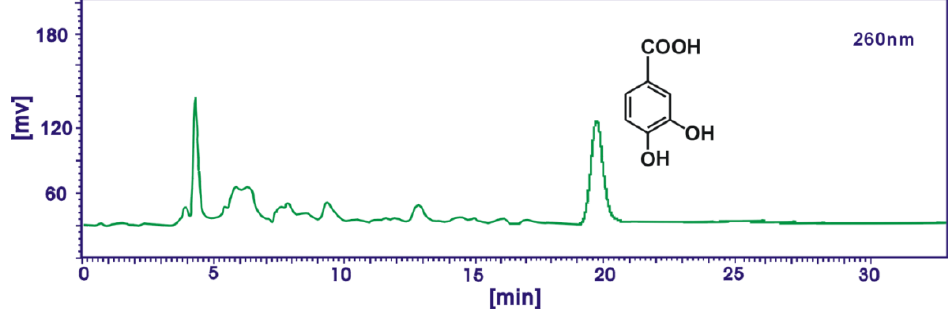
Figure 3. A typical HPLC profile of protocatechuic acid in the ethyl acetate extract of Rhizoma Atractylodes macrocephala . Syltech P510 system (Los Angeles, CA, USA), Dikma Diamonsil C (250 mm × 4.6 mm, 5 μm) column, 1.0 mL/min flow rate, 18